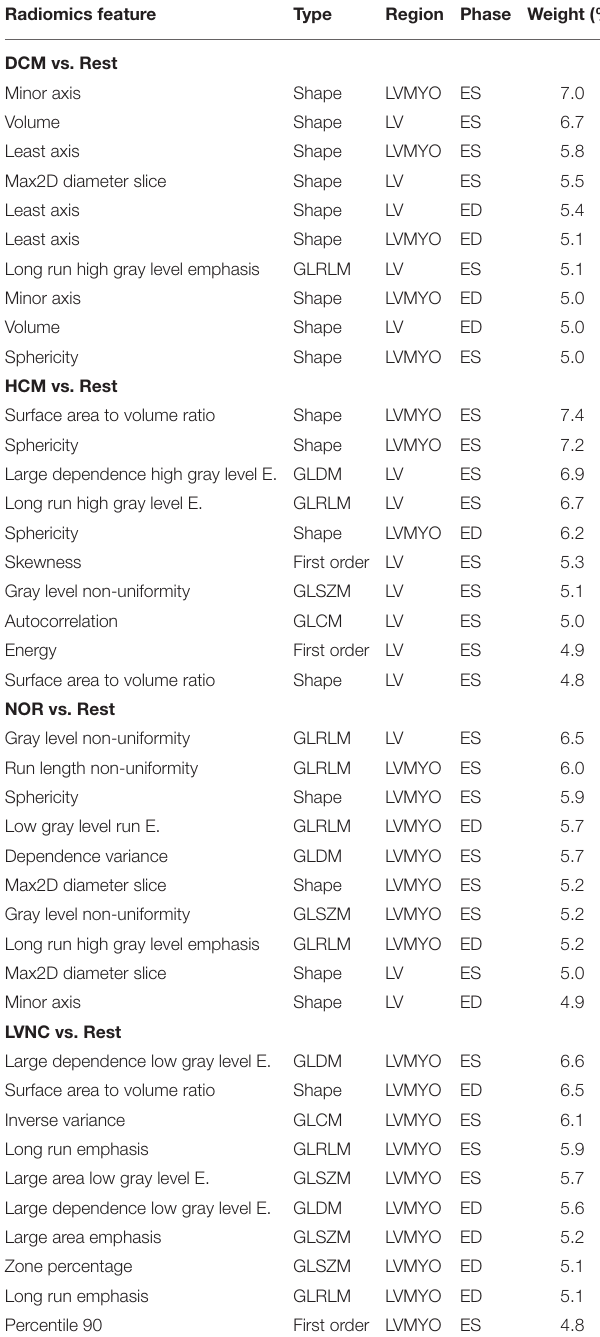
TABLE 6 | Top-10 best performing radiomics for each differential diagnosis, divided across